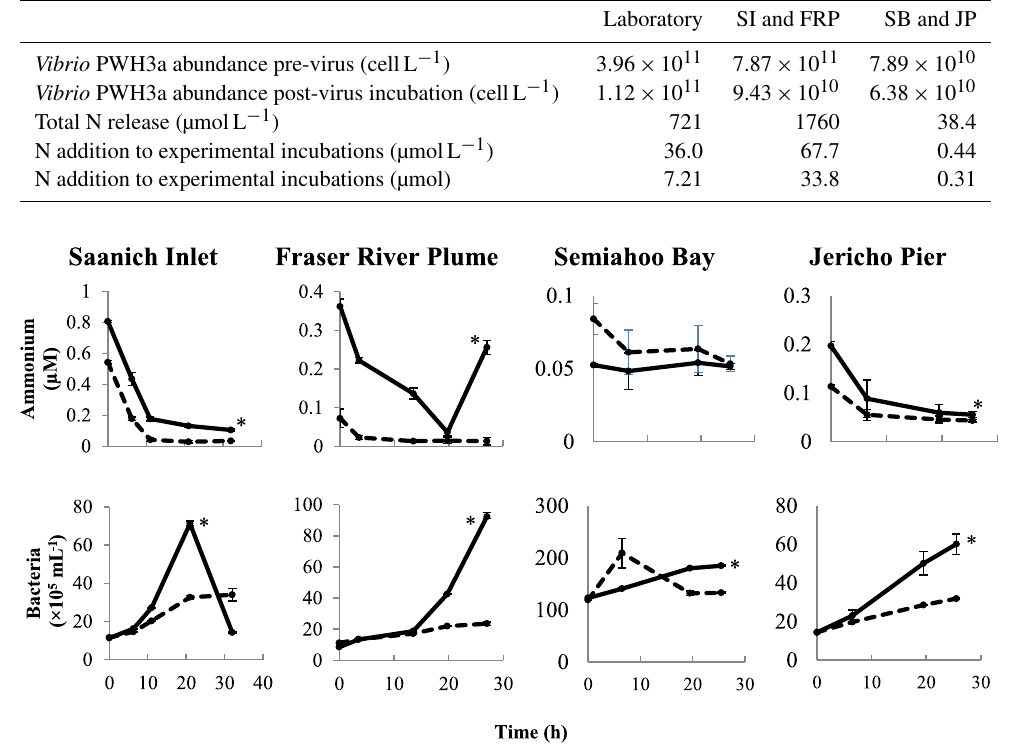
Table 3. Vibrio sp. strain PWH3a dynamics during the creation of lysates by viral infection (Laboratory: experiments with cultured Syne- chococcus ; SI: Saanich Inlet; FRP: Fraser River Plume; SB: Semiahoo Bay; JP: Jericho Pier). N was added at lower concentrations for stations SB and JP to approximate in situ concentrations.